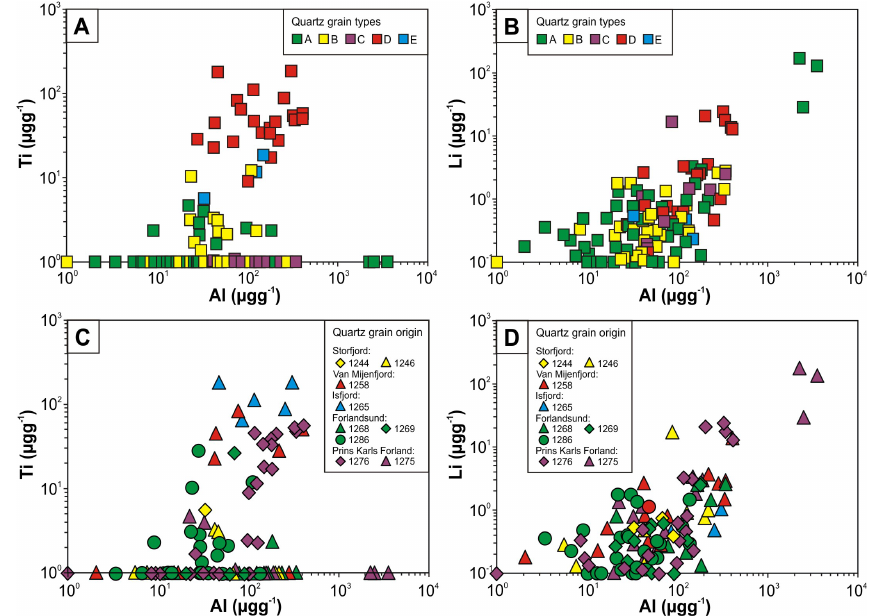
Fig. 6. Concentrations of Al versus Ti and Li of quartz grains in offshore samples. The same data are plotted, first, with respect to quartz type (A, B) and, second, to sample origin (C, D) . (A, B) Type D grains have distinctively high Ti and relatively high average Al and Li compared to the grain types A, B, C, and E. (C, D) Samples 1265 (Isfjord), 1276 (Prins Karls Forland) and 1258 (Van Mijenfjorden) have relatively high proportions of grains with high Ti (D type